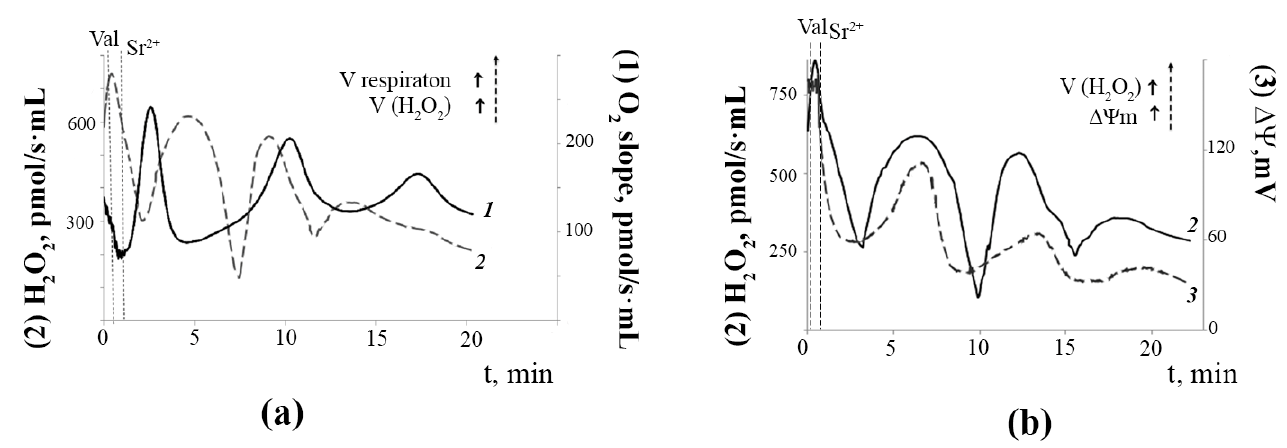
Figure 4. Sr 2+ /valinomycin-induced dynamic changes in the respiration rate (trace 1 ), H 2 O 2 pro- duction rate (trace 2 ), and the membrane potential (trace 3 ) of rat liver mitochondria: ( a ) Reciprocal changes in the rates of oxygen consumption and H 2 O 2 production by rat liver mitochondria after the addition of Sr 2+ and valinomycin. The conditions were the same as in Figure 2. The rate of mito- chondrial respiration (O 2 slope, (pmol/s·ml)) was measured polarographically using an Oxygraph- 2k respirometer and DatLab software (Oroboros Instruments, Innsbruck, Austria). The rate of H 2 O 2 production (H 2 O 2 , (pmol/s·ml)) by the mitochondria was determined by the Amplex Red/peroxi- dase assay. The typical traces are presented ( n = 5); ( b ) Synchronous changes in the rate of H 2 O 2 production and the membrane potential of rat liver mitochondria after the addition of Sr 2+ ions and valinomycin. The conditions were the same as in Figure 2. The mitochondrial membrane potential was estimated with the use of tetraphenylphosphonium (TPP + ) and an electrode selective for TPP + as described in the Materials and Methods section. The amount of TPP + accumulated in mitochon- dria was determined by measuring the difference between its initial concentration and the concen- tration after the addition of mitochondria. The typical traces are presented ( n = 5). The specific blocker of MCUC ruthenium red (1 µM) suppresses the formation of the next oscillation wave of Sr 2+ flux (Figure S2) and the other functional parameters of mito- chondria. In contrast, the inhibitor of cyclophilin D, a key regulator of mPTP opening, cyclosporin A (CsA), did not affect mitochondrial oscillations, and it was added to the incubation medium in all the above experiments to exclude mPTP-related mitochondrial damage.